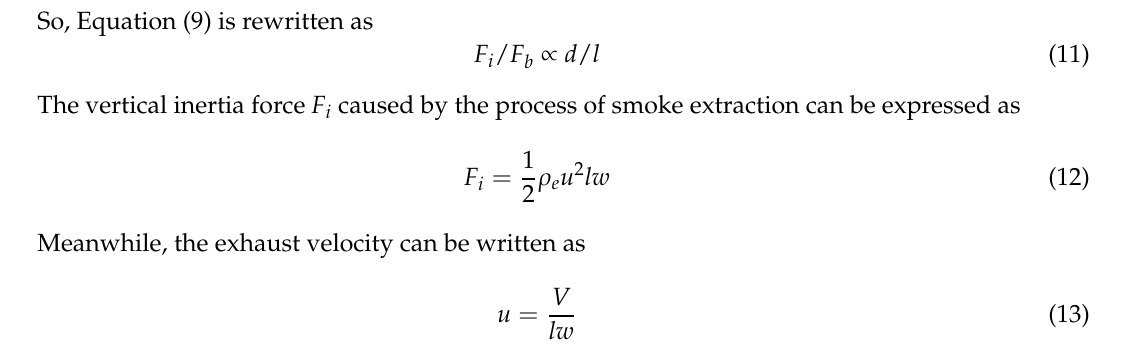
Figure 13. Forces acting at the smoke beneath the extraction.